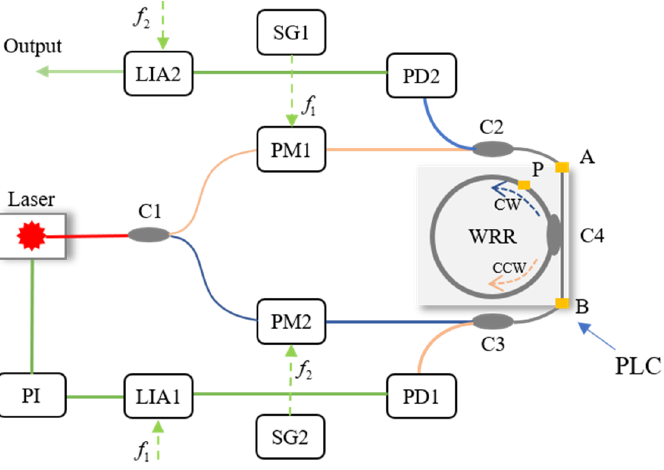
Figure 1. System structure of the RIOG based on single-phase modulation technology.